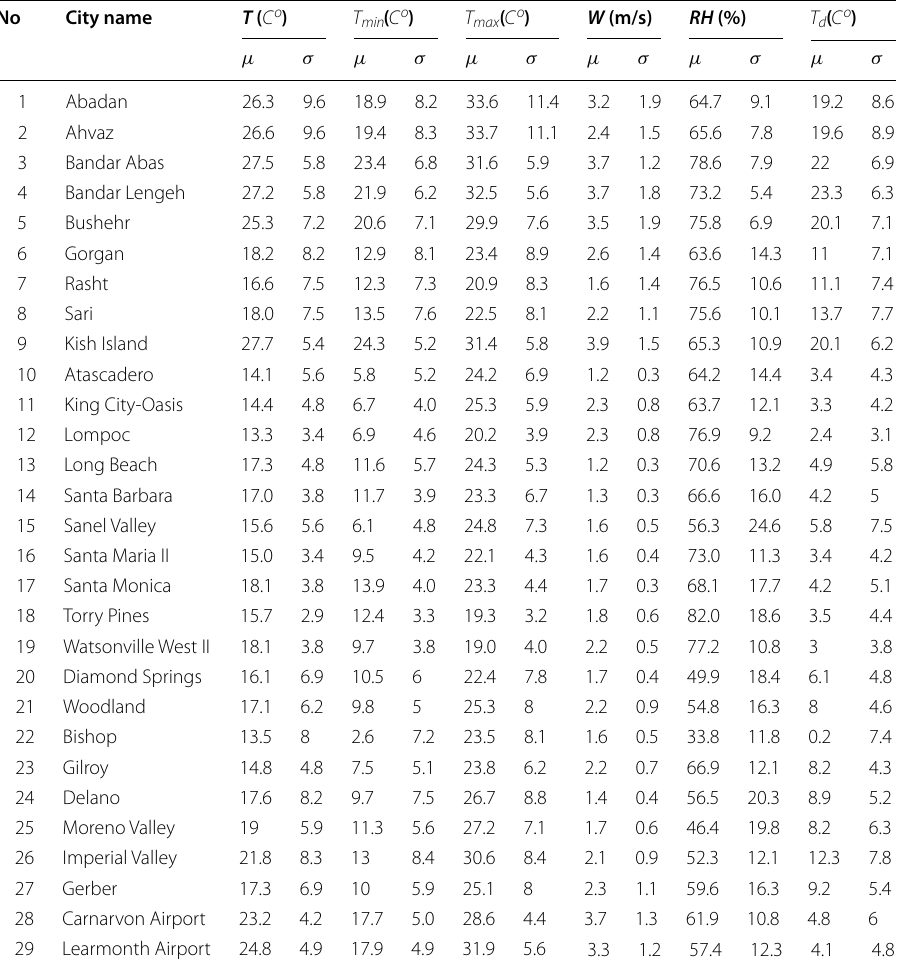
Table 3 The mean (μ) and standard deviation (σ) values were calculated for each selected coastal station